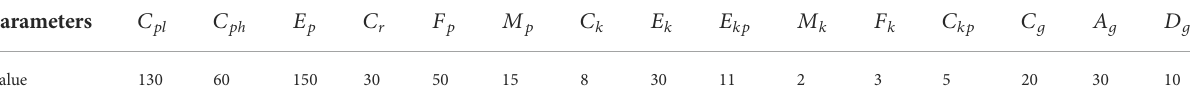
TABLE 3 Parameter values for each stage in the evolutionary game model.